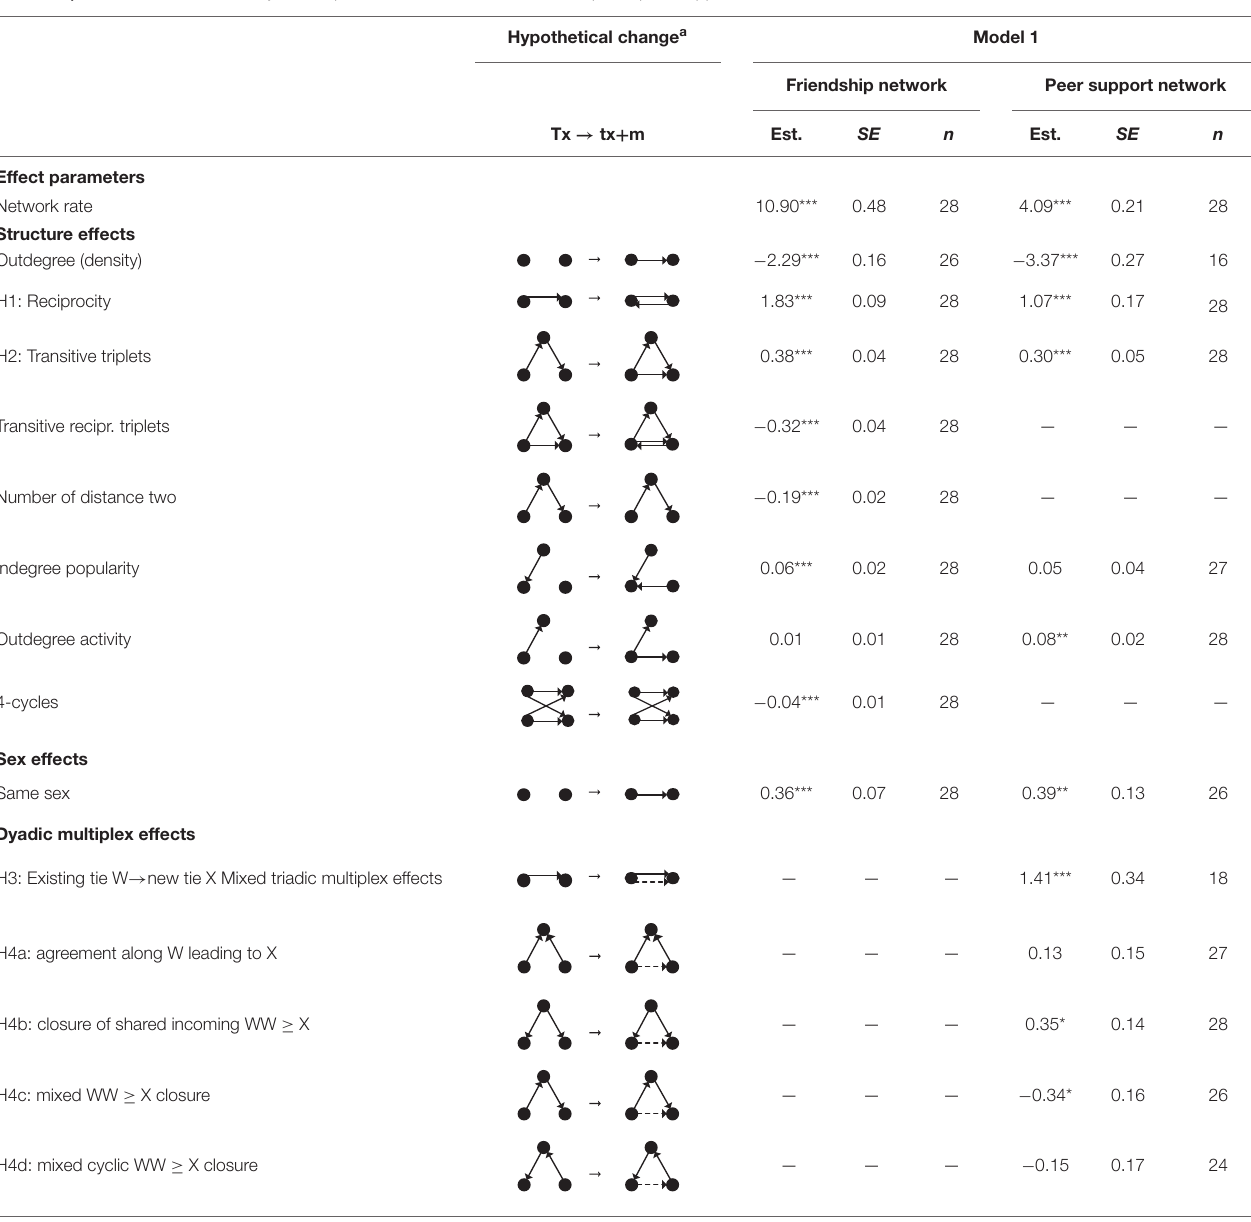
TABLE 4 | Results from RSiena analysis that predicted the influence of friendships on peer